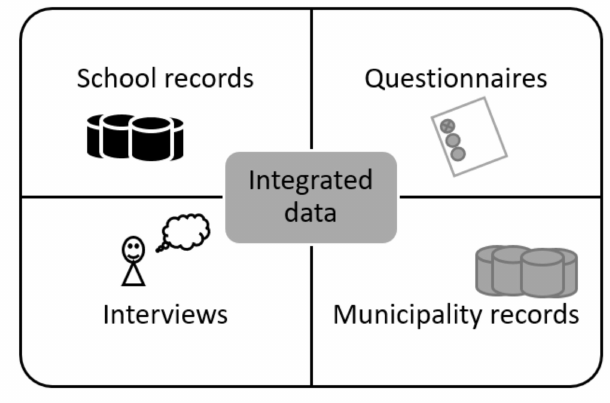
Figure 1. Data integration